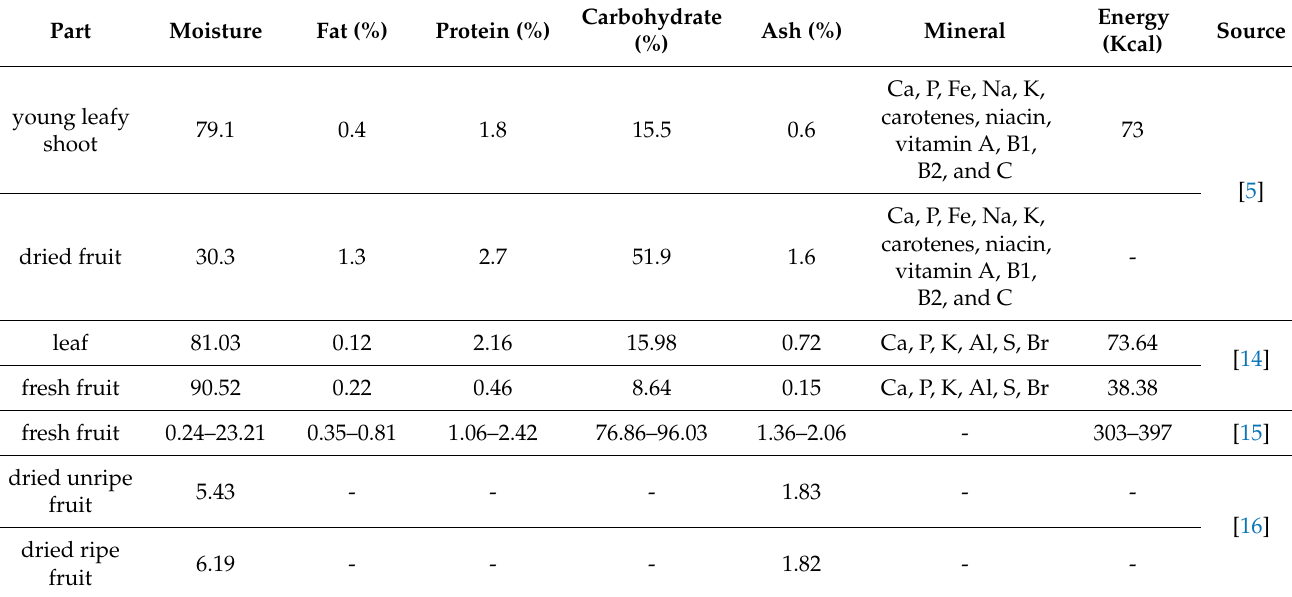
Table 1. Proximate composition of G. atroviridis